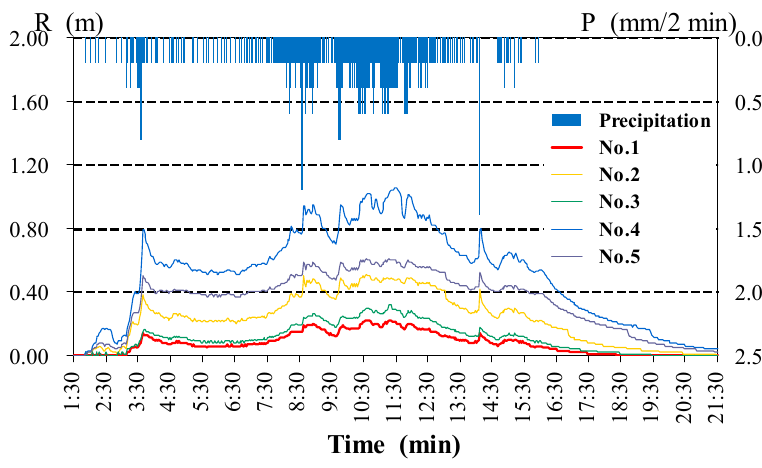
Figure 6. Simulated “7.20” runoff processes at different positions.